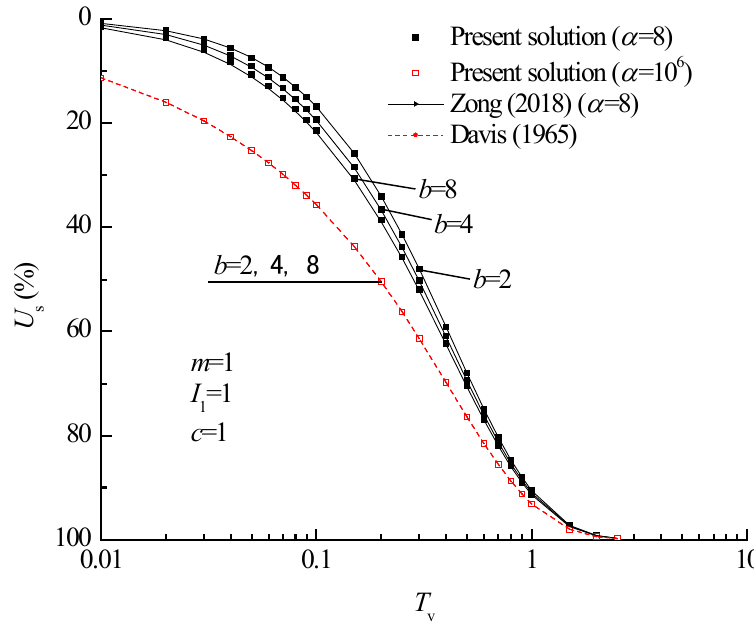
Figure 2. Comparison of analytical solutions and numerical solutions [17,44].